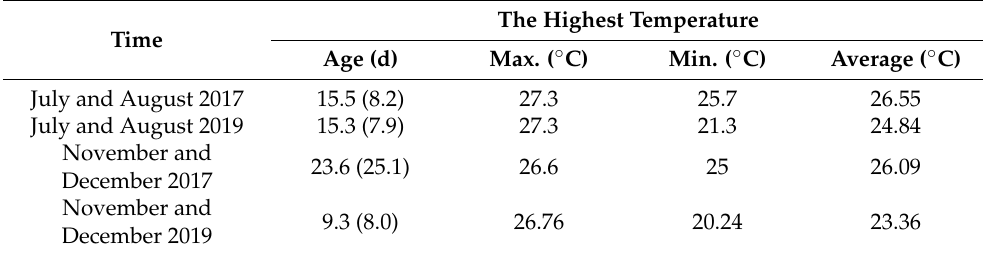
Table 6. Statistics of the highest temperature of concrete blocks of the WDD dam.